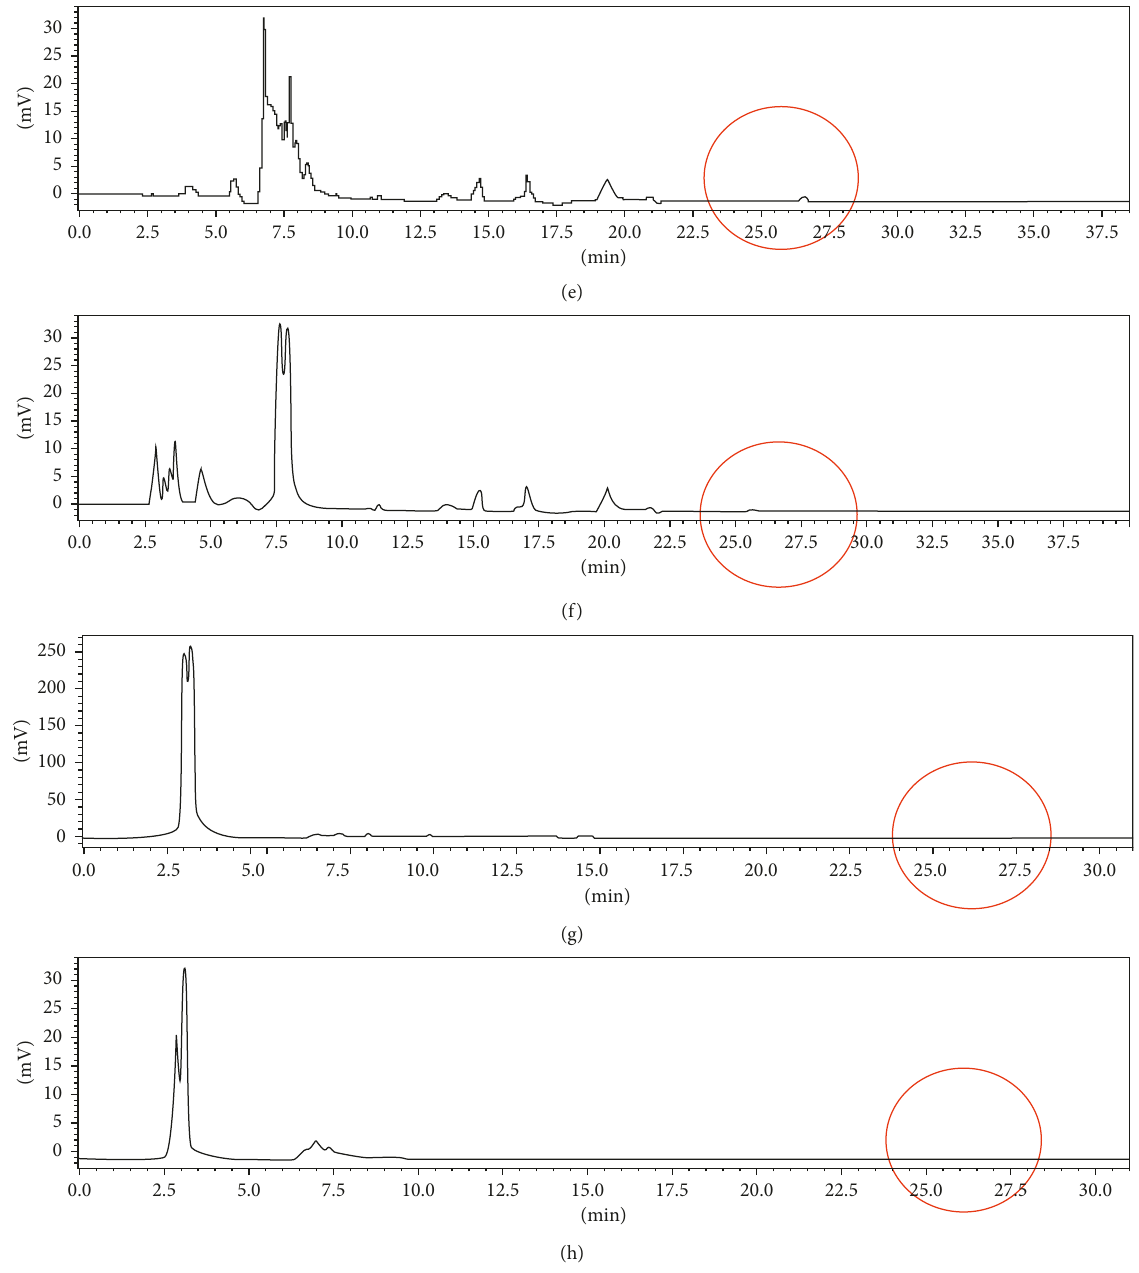
Figure 8: HPLC chromatogram profiles of C. papaya leaves extract (a) standard (escin); (b) fresh (untreated); (c–h) samples treated with ion exchange resins. Red circle in (b–h) shows the retention time of the saponin compound. (a) Peak of standard (control: escin) at con- centration of 100 mg/l using 210 nm detection wavelength. (b) Peak of fresh sample (untreated) using 210 nm detection wavelength. (c) No peak detected at the expected retention time of samples treated with Diaion WA21 resin at 5% (w/v) adsorbent dose using 210nm detection wavelength. (d) No peak detected at the expected retention time of samples treated with Diaion WA21 resin at 10% (w/v) adsorbent dose using 210 nm detection wavelength. (e) No peak detected at the expected retention time of samples treated with Amberlite IRA-67 resin at 5% (w/v) adsorbent dose using 210nm detection wavelength. (f) No peak detected at the expected retention time of samples treated with Amberlite IRA-67 resin at 10% (w/v) adsorbent dose using 210nm detection wavelength. (g) No peak detected at the expected retention time of samples treated with Diaion WA-30 resin at 5% (w/v) adsorbent dose using 210 nm detection wavelength. (h) No peak detected at the expected retention time of samples treated with Diaion WA-30 resin at 10% (w/v) adsorbent dose using 210nm detection